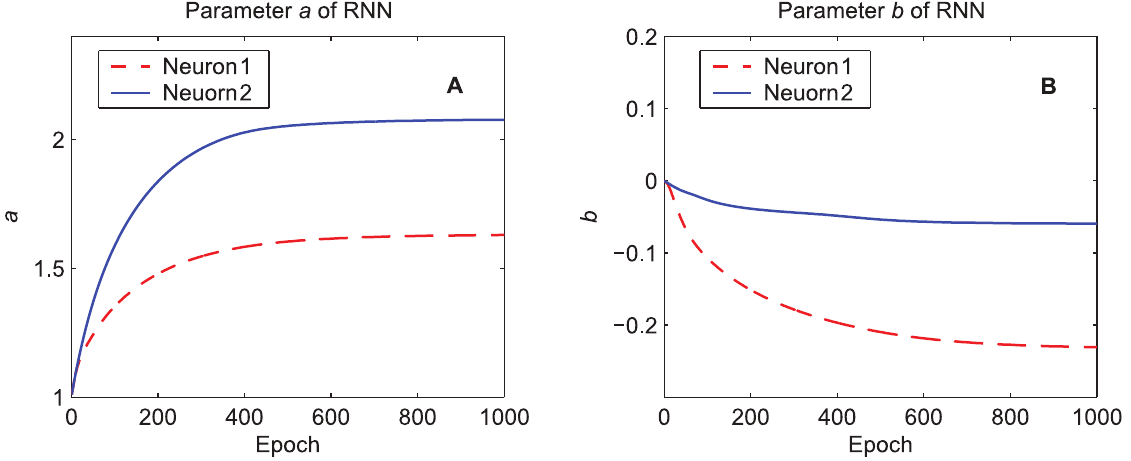
Figure 14. Evolution of the parameters of the activation functions in the RNN. The training data set ‘‘MG’’ is used. (A) The gain parameter a . (B) The bias parameter b .